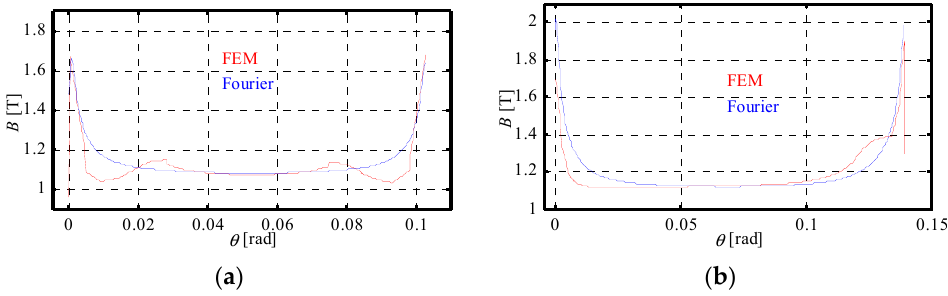
Figure 18. Flux density on the tooth base in open-circuit operation: ( a ) Qs48p8, ( b ) Qs36p15.